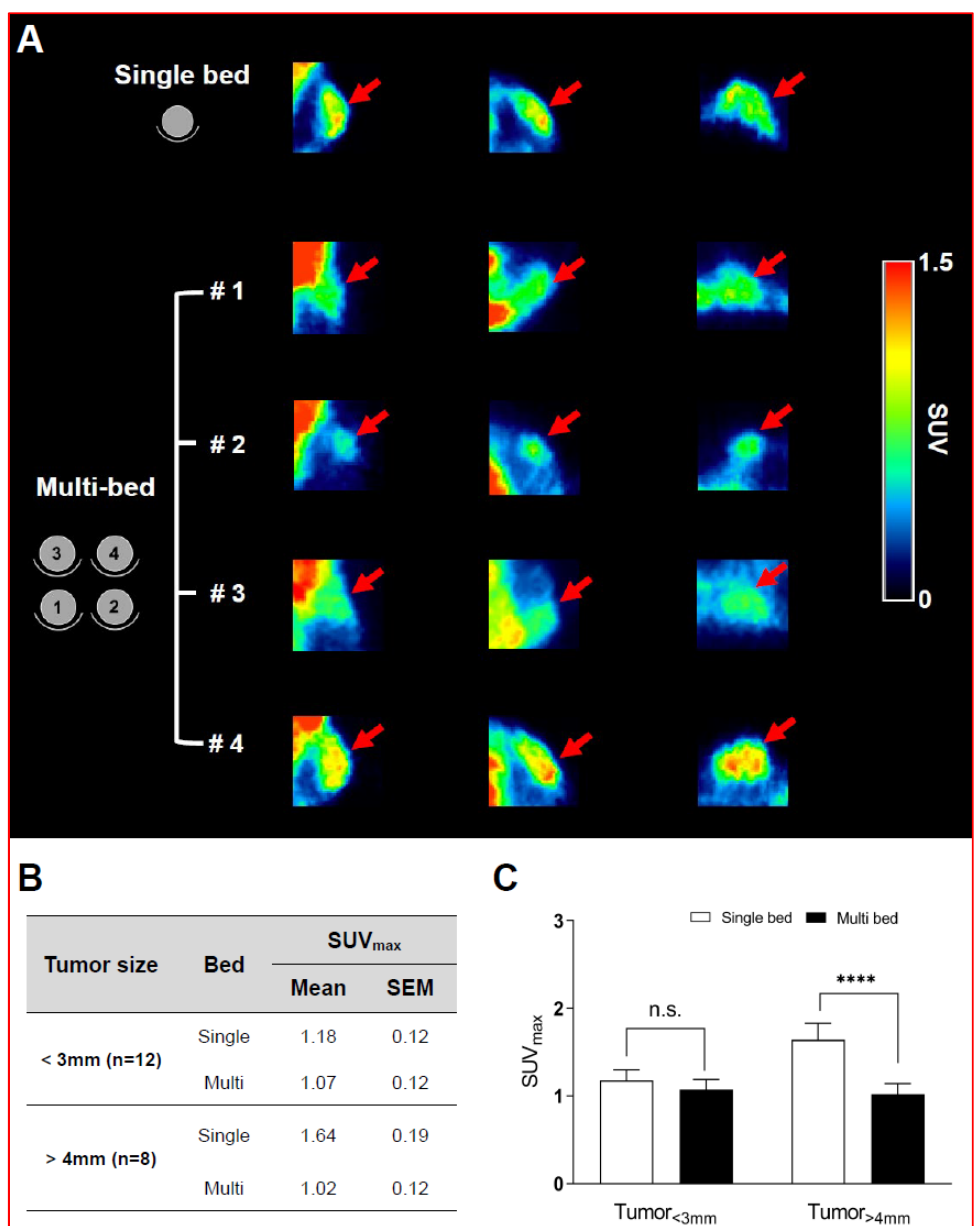
Figure 3. Representative PET/CT images of tumor-bearing mice after 18 F-FDG injection in single- and multi-bed systems ( A ). The plane was chosen to best reflect the tracer uptake characteristics of each group. Comparison of tumor uptake values in single- and multi-bed systems based on tumor size ( B , C ), **** p < 0.0001, n.s.= statistically nonsignificant. PET/CT, positron emission tomography/computed tomography; SUV max, maximum standardized uptake value.